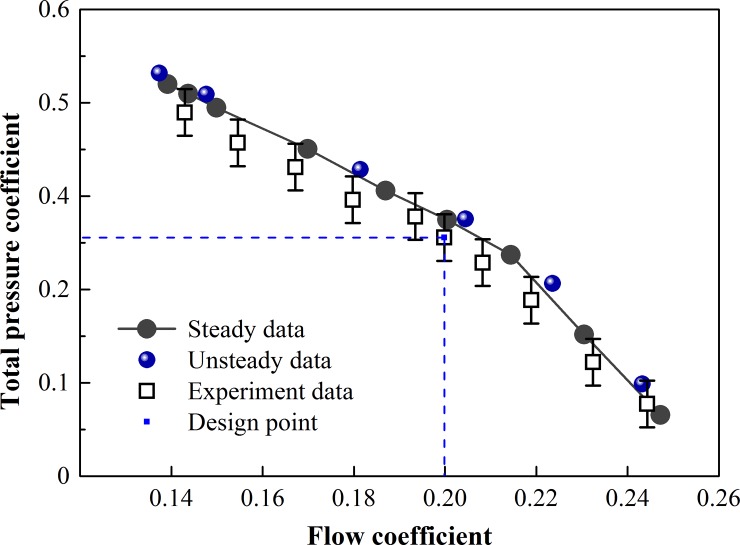
Curve of numerical and experimental total pressure rise performance.